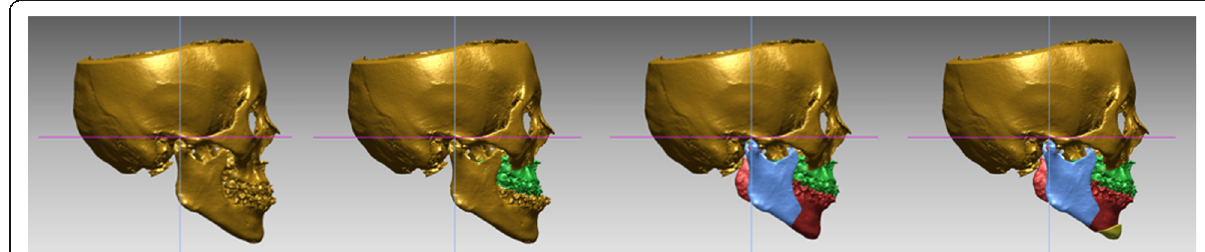
Fig. 2 Virtual surgery in virtual surgical